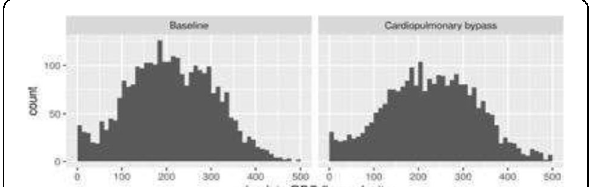
Fig. 3 (abstract 0333). Absolute RBC velocity frequency histograms before and after initiation of CPB.